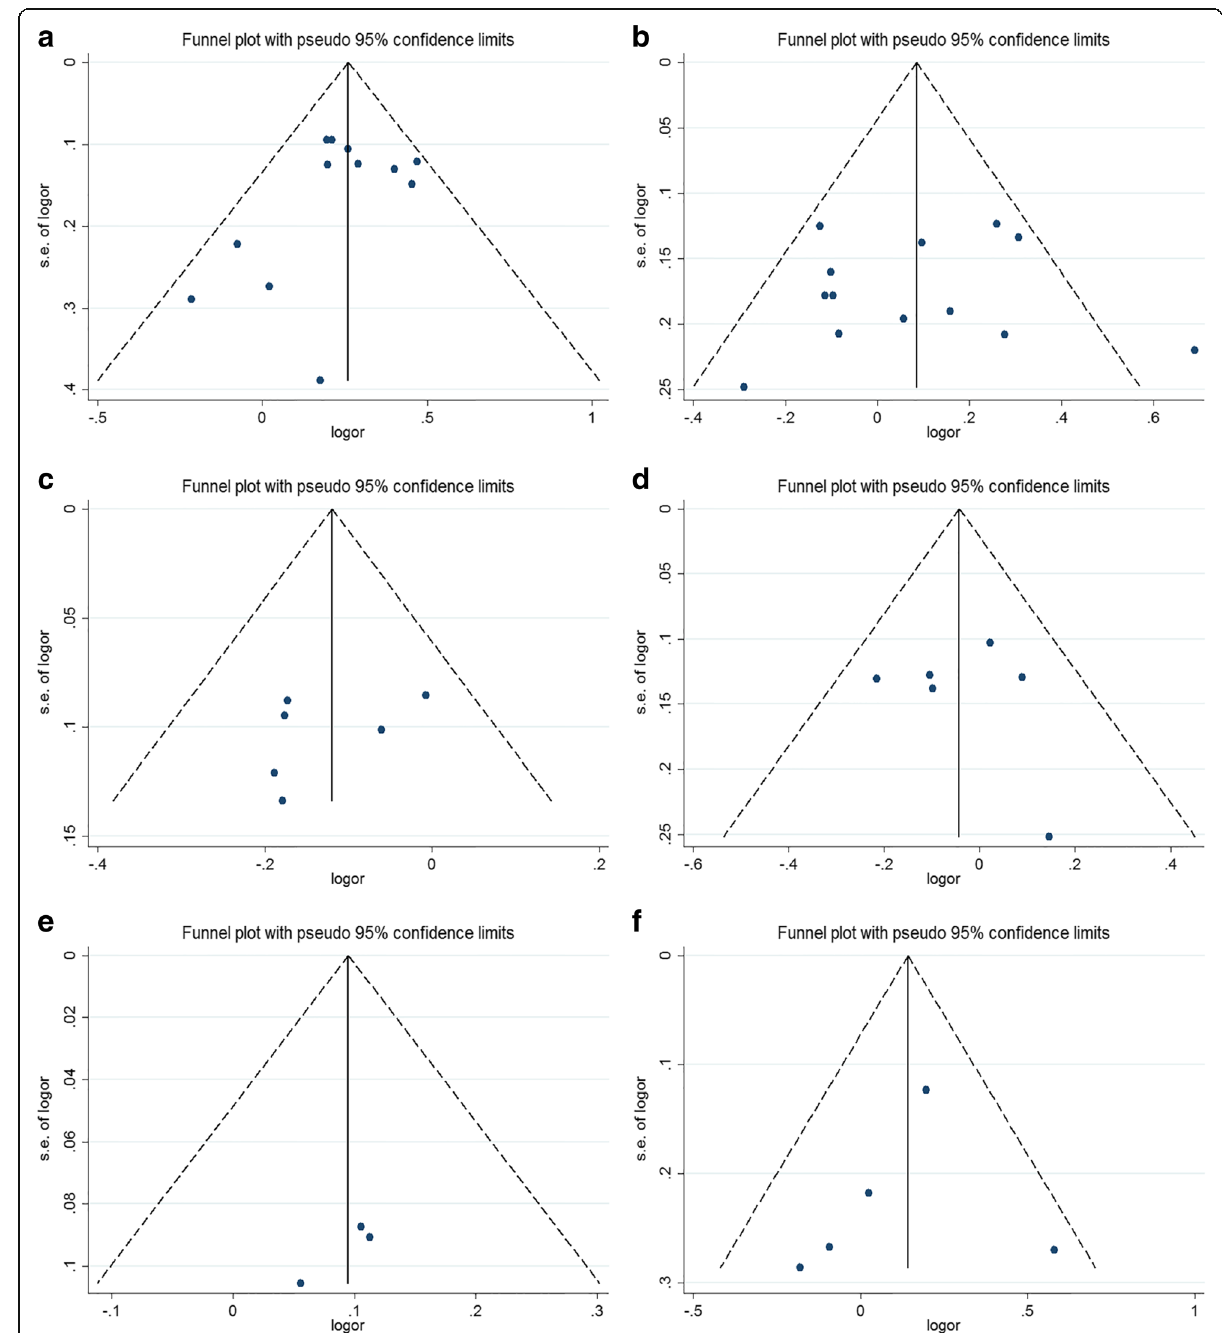
Fig. 3 Funnel plots for HOTAIR polymorphisms and cancer risk in heterozygous model. a rs920778, b rs4759314, c rs7958904, d